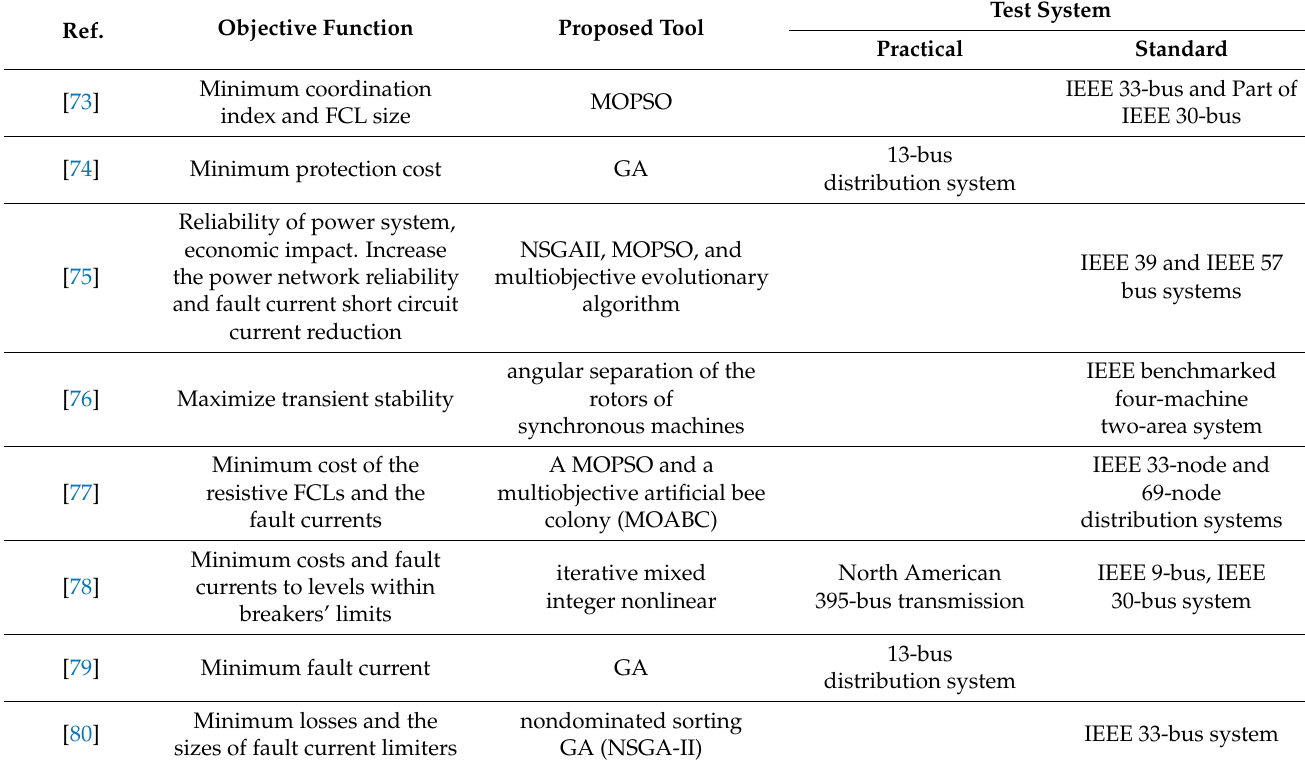
Table 1. Different techniques for FCLs optimal